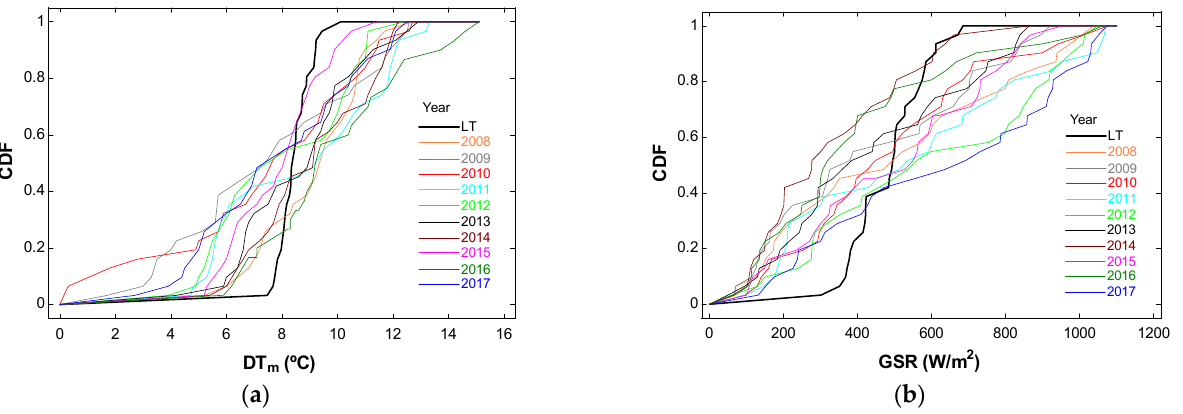
Figure 3. Santiago EOAS Station, the month of January (R Statistics [25]): ( a ) Representation of CDF functions for the Daily Mean Temperature index; ( b ) Representation of CDF functions for the Daily Mean Horizontal Global Radiation index.